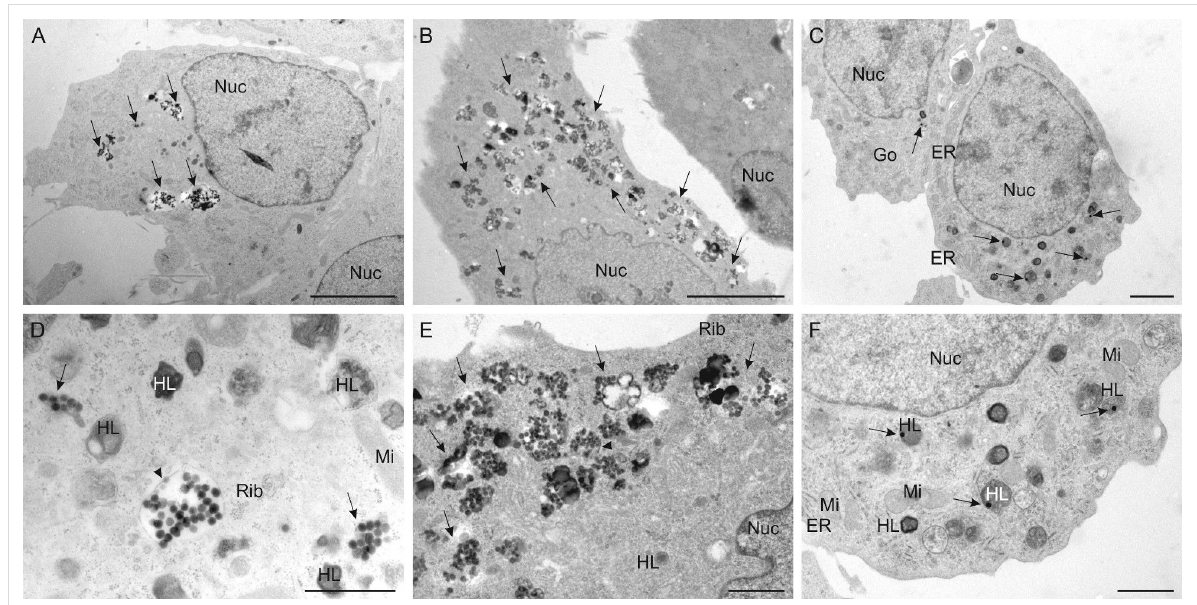
Figure 2: Uptake of PLLA-NPs (A, D) after 2 h of exposure and uptake of PCL-NPs (B, E) and Au-NPs (C, F) into rBCEC4 cells after 24 h of expo- sure; cell overview (A, B, C) and higher magnification (D, E, F); analyzed by TEM. PLLA- and PCL-NPs were found in clusters inside the cells (arrows) (A, B; scale bar: 5 µm) and were present freely in the cytoplasm (arrows) or in membrane-bound vesicles (arrow head) (D, E; scale bar: 1 µm). Single Au-NPs were taken up by the cells (arrows) (C; scale bar: 2 µm) and co-localized with heterolysosomes (arrows) (F; scale bar: 1 µm). Nuc = nucleus, HL = heterolysosomes, Rib = free ribosomes; Mi = mitochondria; Go = Golgi apparatus; ER = endoplasmic reticulum. Concentrations were [24.9 µg/mL] PLLA- or PCL-NPs and [160.3 µg/mL] Au-NPs.